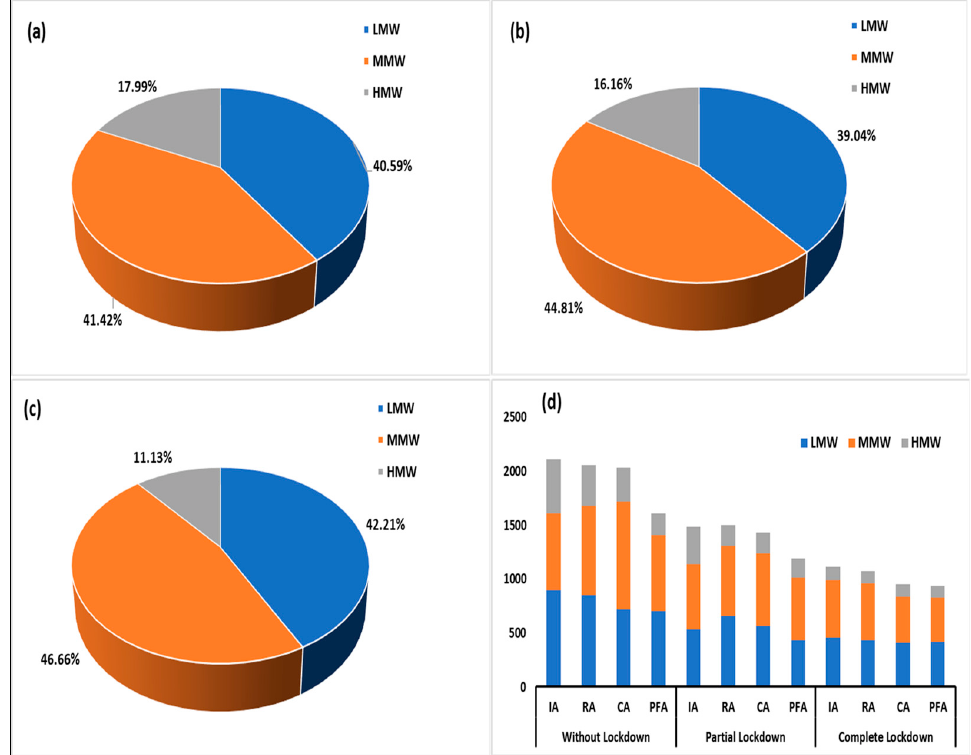
Figure 5. Average distribution of PAHs by molecular weights during: ( a ) without lockdown, ( b ) partial lockdown, and ( c ) complete lockdown; and ( d ) Concentration and proportion of total PAHs with three molecular weight groups in different land use categories of street dust during without, partial and complete lockdown.